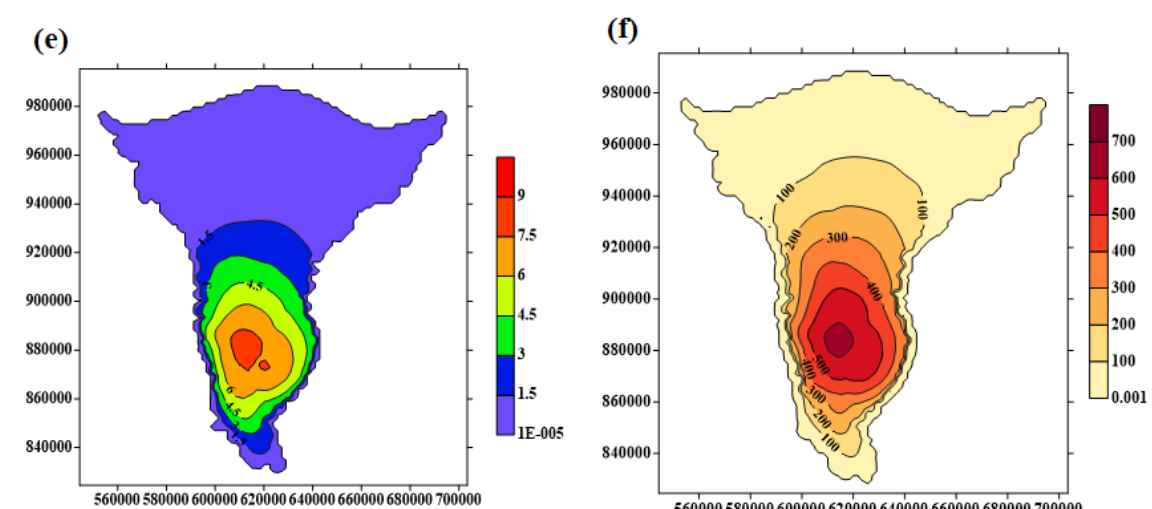
Figure 10. Results of drawdown in (m) and Land subsidence in (mm) in the MND due to combination of increasing abstraction and decreasing recharge. ( a ) GW drawdown during 2010 to 2030, ( b ) LS during 2010 to 2030, ( c ) GW drawdown during 2010 to 2050, ( d ) LS during 2010 to 2050, ( e ) GW drawdown during 2010 to 2070, ( f ) LS during 2010 to 2070.